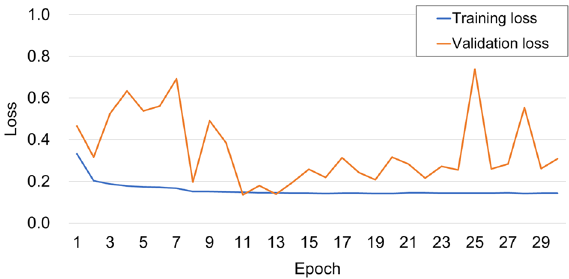
Figure 4. Training and validation losses for the number of epochs.